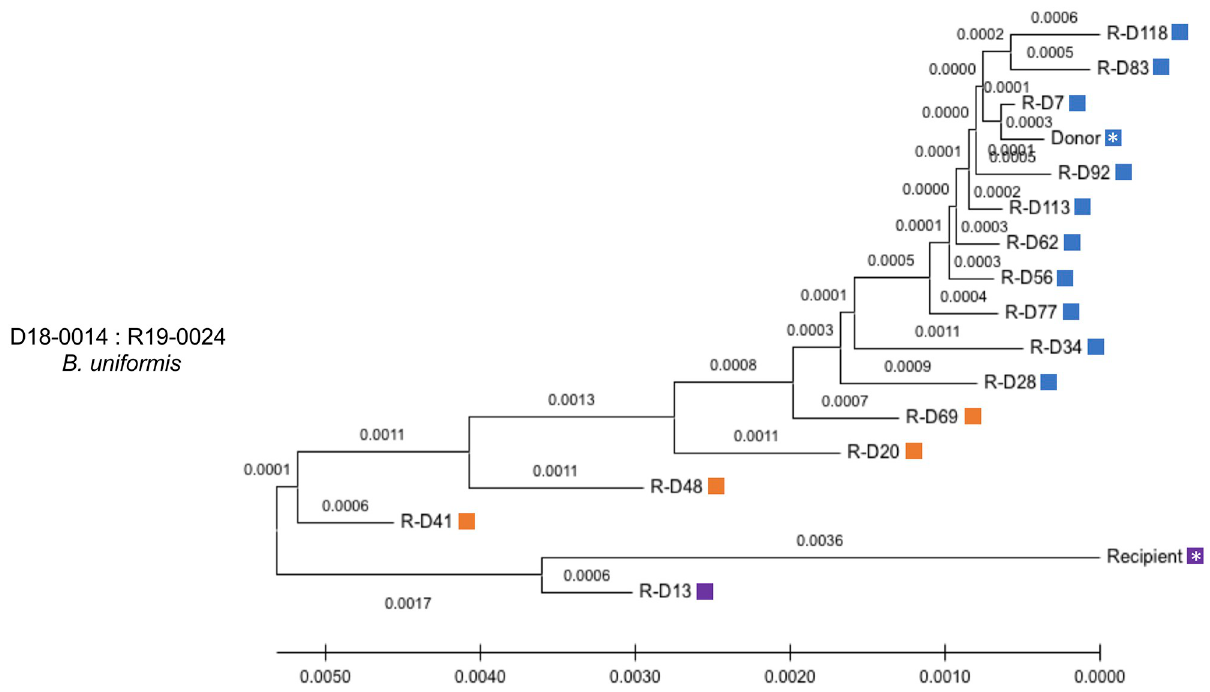
Fig 3. StrainPhlAn analysis for B . uniformis from FMT donor 18–0014 and recipient 19–0024 pair. StrainPhlAn analysis on FMT pair donor 18– 0014 and recipient 19–0024 was done for B . uniformis across all samples in this pair. A neighbor-joining (NJ) tree was built and the tree is drawn to scale with branch lengths. Then, the distances were calculated using the Maximum Composite Likelihood method and are in the units of the number of base substitutions per site using MEGA X. The blue and purple color boxes shown next to the NJ tree match the color boxes shown in Fig 2A and the orange color boxes indicate a recombinant strain which is shown as both numerical numbers in Fig 2A. A white asterisk indicates a donor and recipient pre FMT sample.